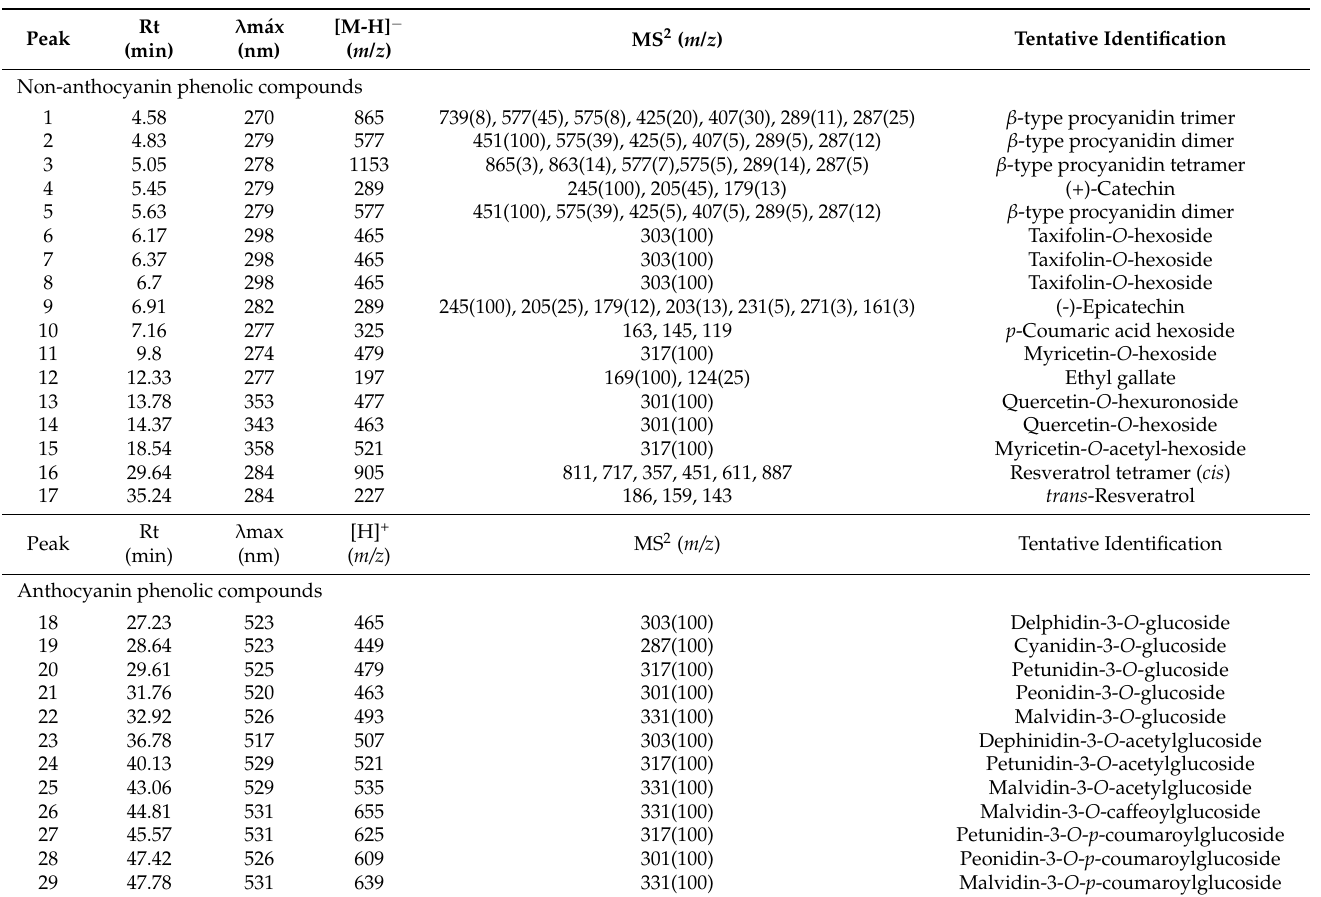
Table 1. Retention time (Rt), wavelength at the maximum absorption ( λ m á x), mass spectra ( m / z ), and tentative identification of the non-anthocyanin and anthocyanin phenolic compounds found in winemaking residues from the year